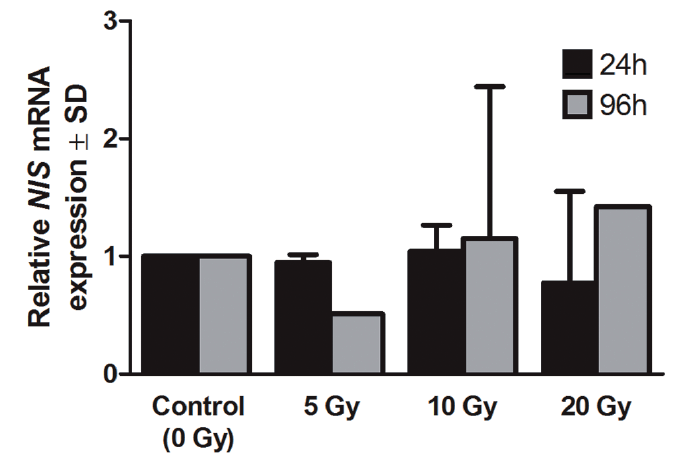
Figure 3. Expression of sodium iodide symporter ( NIS ) gene by human thyrocytes in culture with 131 I. The graph shows relative NIS gene expression (±SD) obtained from human thyrocytes directly after 24 h of 131 I exposure (5, 10, 20 Gy) or after additional 72 h of culture without 131